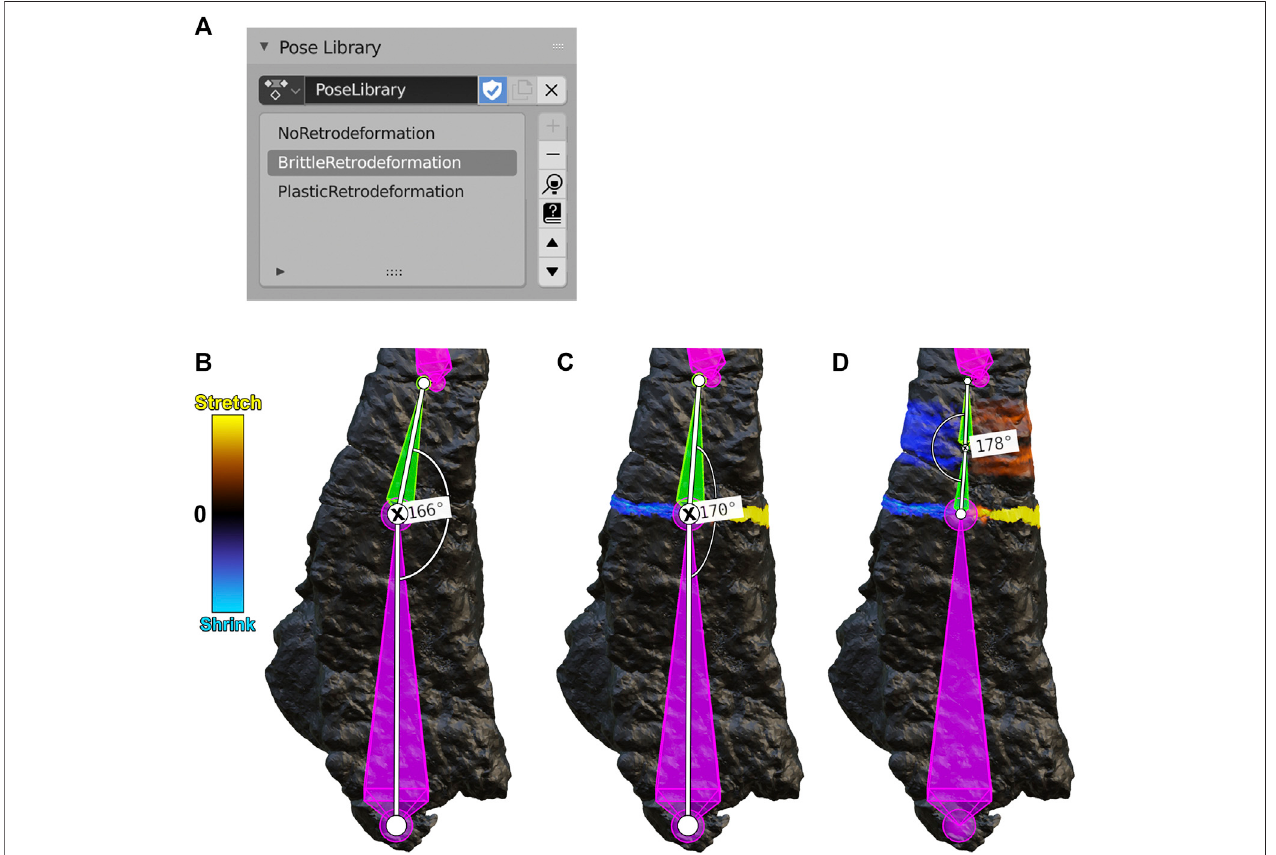
FIGURE 5 | (A) A Blender Pose Library panel containing three poses for the frontal bone (B-D, below). (B) A NoRetrodeformation pose in which no armature segmenthasbeenrepositioned. (C) ABrittleRetrodeformationposeinwhichsegment5(green)wasrotatedtoclosethegapbetweenfragment5andfragment6.During this process, segment 5 was rotated counterclockwise a total of four degrees, as shown by the angle measurements (the rotated joint is marked with an X). (D) A PlasticRetrodeformationposeinwhichthesecondsubsegmentofsegment5wasrotatedcounterclockwisebytwodegrees,plasticallyretrodeformingfragment5. Segments and fragments are numbered according to Figure 2